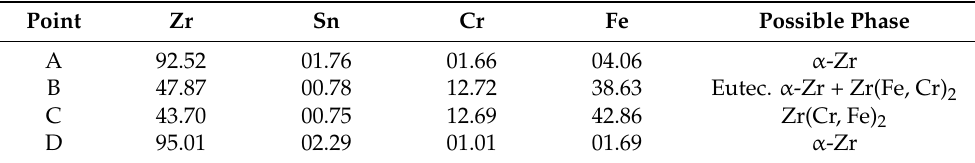
Figure 4. SEM images of the magnified microstructure of diffusion interface under 820 °C/7 MPa/60 min, and ( b ) is a magnification image in ( a ). Table 3. Chemical composition and possible phase of each point marked in Figure 4b (at. %).